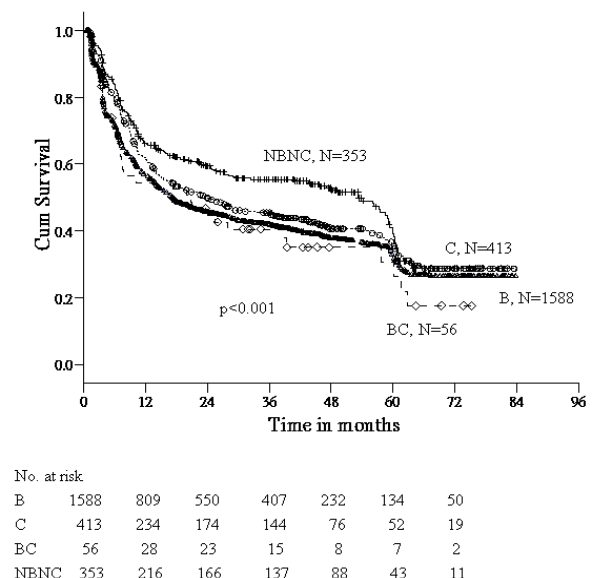
Figure 2. Recurrence-free survival after resection of HCC, stratified by viral etiology. Table 3. Risk of recurrence-free survival for HCC patients receiving hepatic resection. Variable